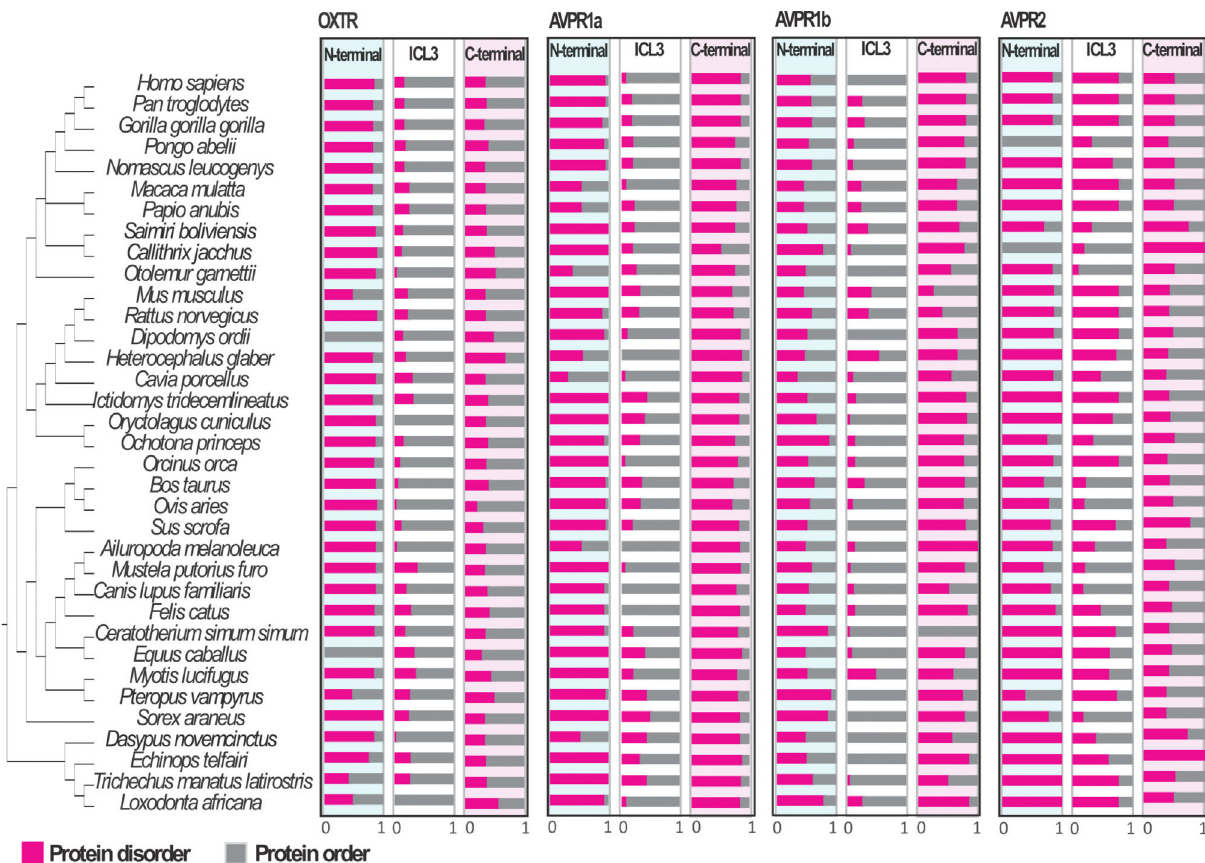
Figure 3 - Protein disorder content for N-terminal, ICL3, and C-terminal regions between paralogues and among orthologues of OXTR, AVPR1a, AVPR1b, and AVPR2.